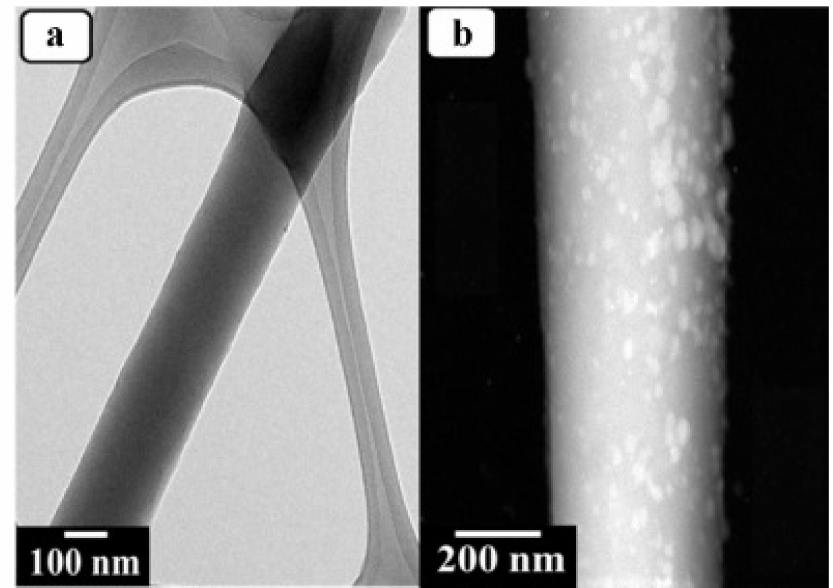
Figure 12. Transmission electron microscopy (TEM) images of ( a ) polyacrylonitrile (PAN) and ( b ) Ag 3 PO 4 /PAN composite membranes used for photodegradation and antimicrobial studies by Panthi et al. Reprinted from [129] with permission from